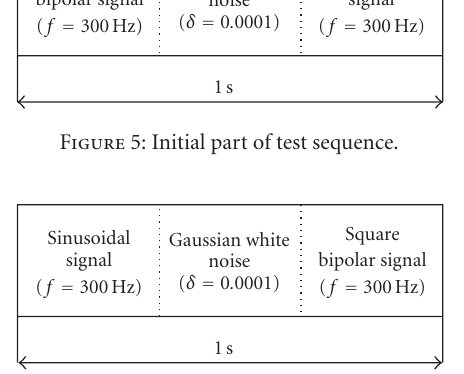
Figure 7: Tra ffi c load for given testing conditions. The vertical bars Figure 6: Second part of test sequence. show 95% CI (derived from 10 measurements) for each testing con- dition. The testing condition numbers correspond to Table